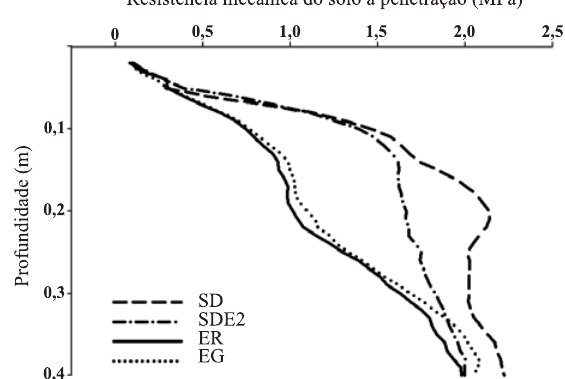
Figura 1. Resistência mecânica do solo à penetração nos diferentes sistemas de preparo do solo. SD: Semeadura direta; SDE2: Semeadura direta com escarificação a cada 2 anos; ER: Escarificação com escarificador munido de rolo destorroador; EG: Escarificação seguida de